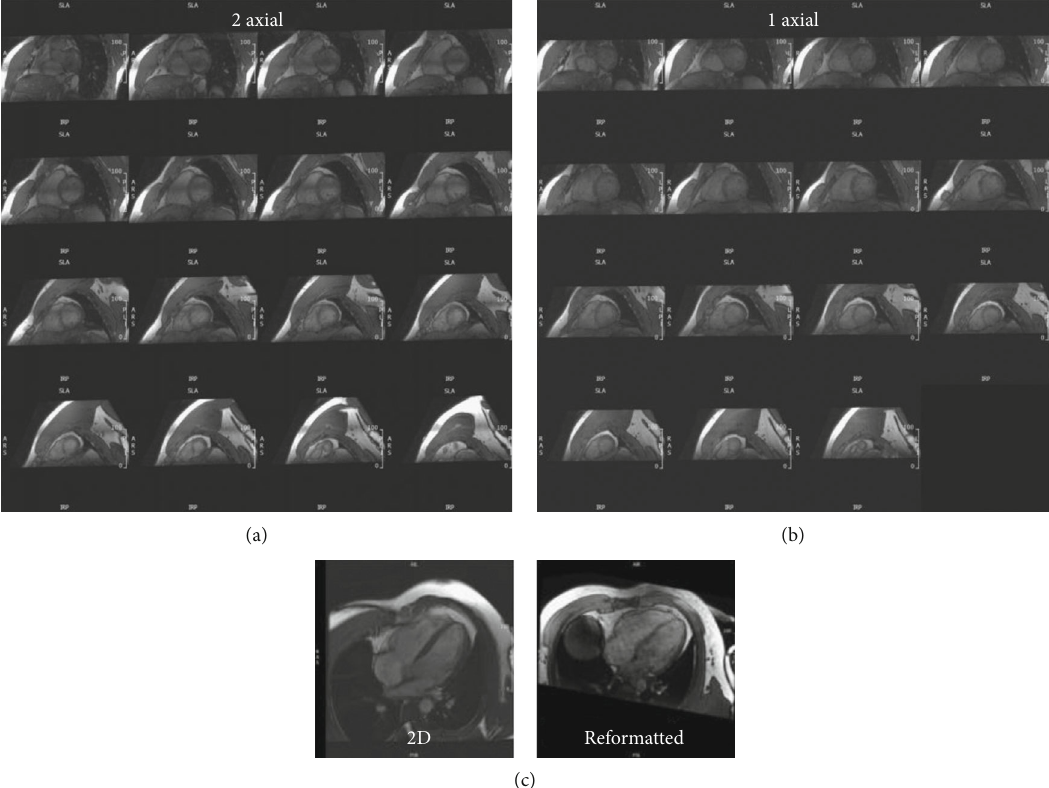
Figure 3: 3D cine acquisition in the axial direction. Reformatted short-axis slices, covering the heart from base (top left) to apex (bottom right), obtained in the same subject as in Figures 1 and 2 using accelerated semi-isotropic 3D-cine acquisition with 2 overlapping axial slabs (a) and one thicker axial slab (b). Scan time is 48 s and 21s for the 2-slabs and 1-slab axial acquisitions, respectively. (c) Four- chamber slice reformatted from the semi-isotropic 3D-cine acquisition (right) and a corresponding slice acquired using conventional 2D cine imaging